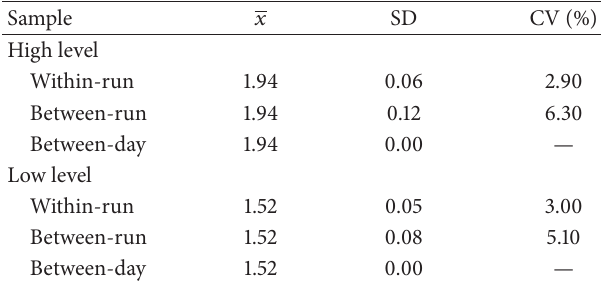
Table 1: Average area of serum diffusion, standard deviation of the area of serum diffusion, and coefficient of variation of the area of serum diffusion at different levels (cm 2 ).